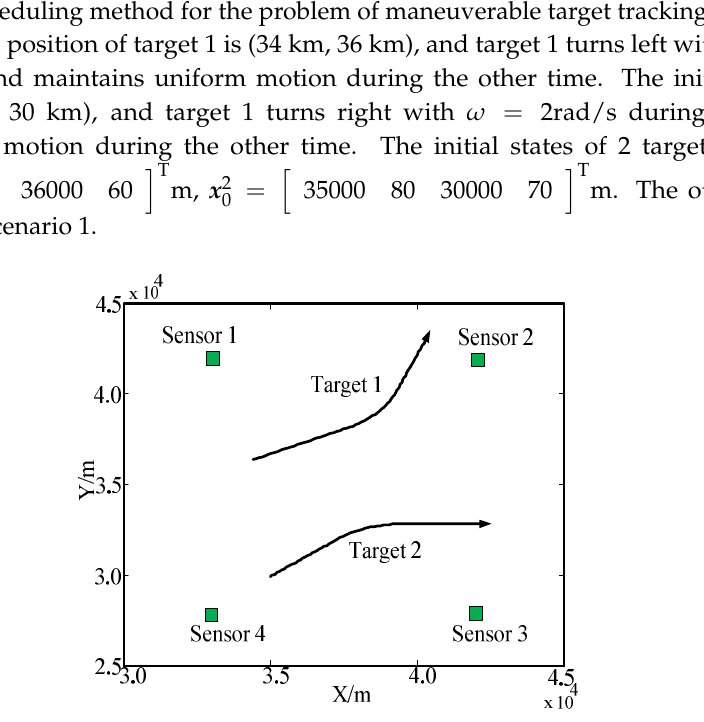
Figure 20 . Sensor selected sequences obtained by IPFSP. ( a ) Target 1; ( b ) Target 2. Figure 19 and Figure 20 show the sensor selected sequence for the two maneuverable targets by BDSP and IPFSP methods, respectively. Obviously, in this scenario, the proposed method can also realize the effective scheduling of sensors to track maneuverable targets, which proves the wide applicability of the proposed sensor scheduling method.